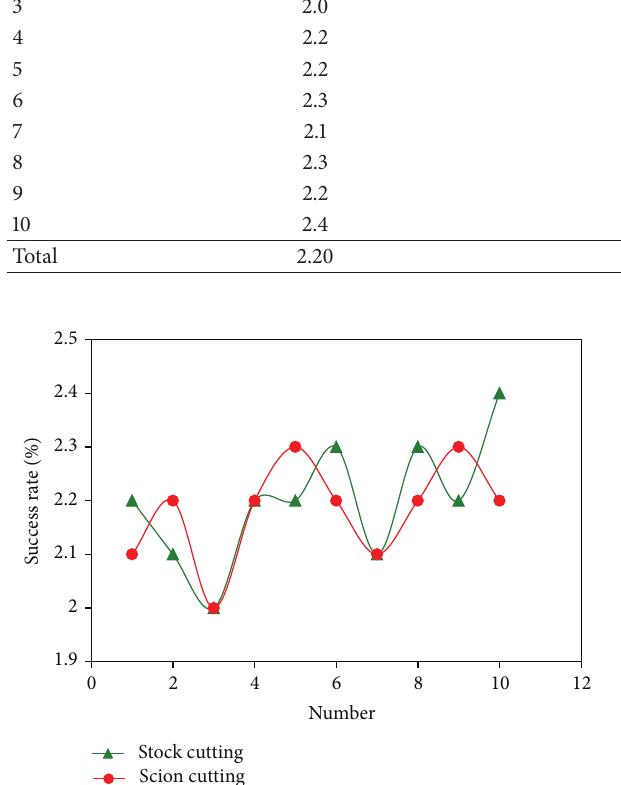
Figure 16: Curves of consumption time for stock cutting and scion